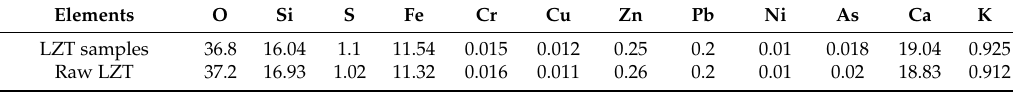
Table 1. Comparison of elemental composition between lead–zinc tailing (LZT) samples and raw LZT